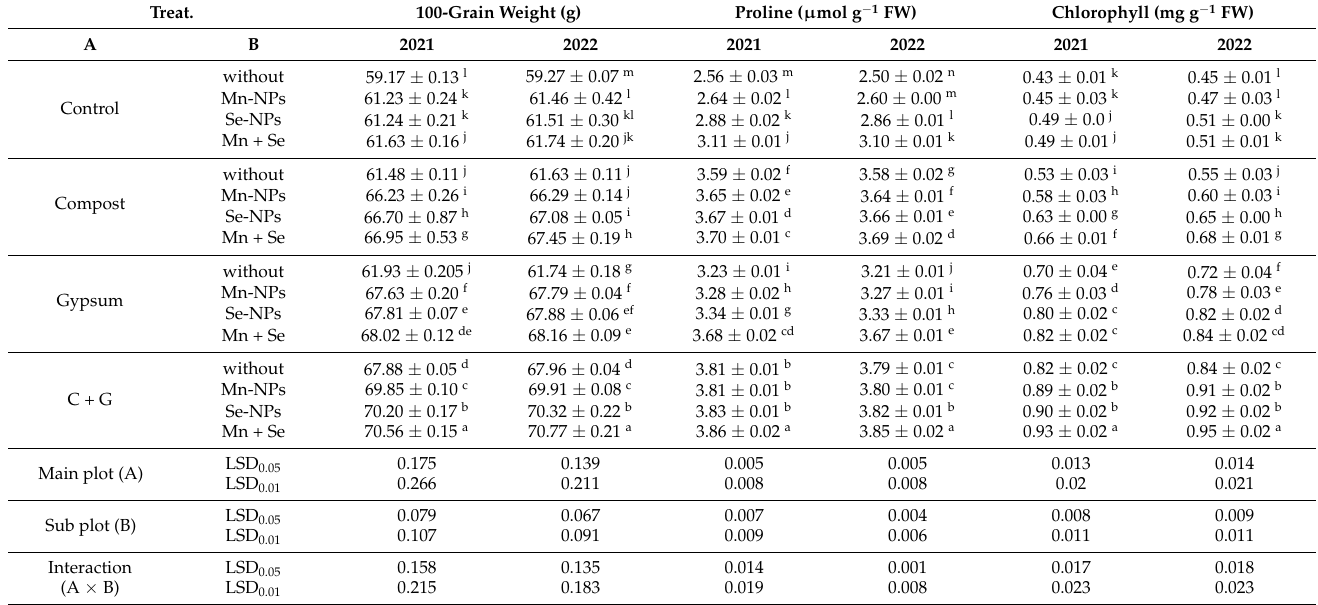
Table 4. Combined effects of soil amendments and foliar application of some nanoparticles on 100-grain weight and proline and chlorophyll contents (mg g − 1 FW) in faba beans for the 2020/2021 and 2021/2022growing